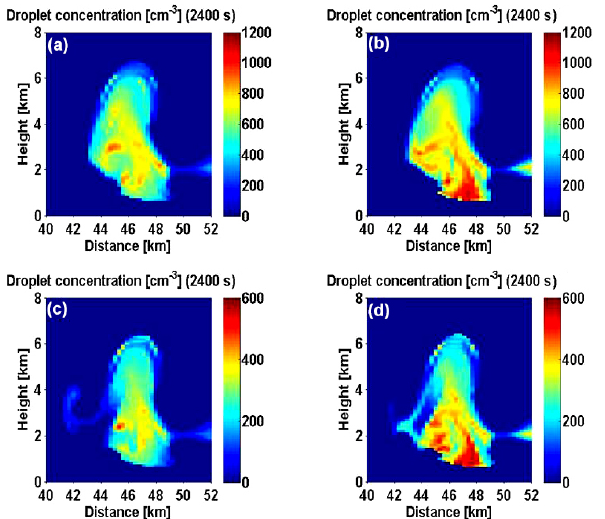
Figure 4. Vertical profiles of the maximum values of droplet con- centration (a, d) and CWC (b, d) in simulations with high CCN con- centration. The profiles are obtained by averaging over the time pe- riod of 2400–3000s (upper row) and over the time period of 4860– 5460s (bottom row). Panel (c) shows a zoom of panel (b) for large CWC.